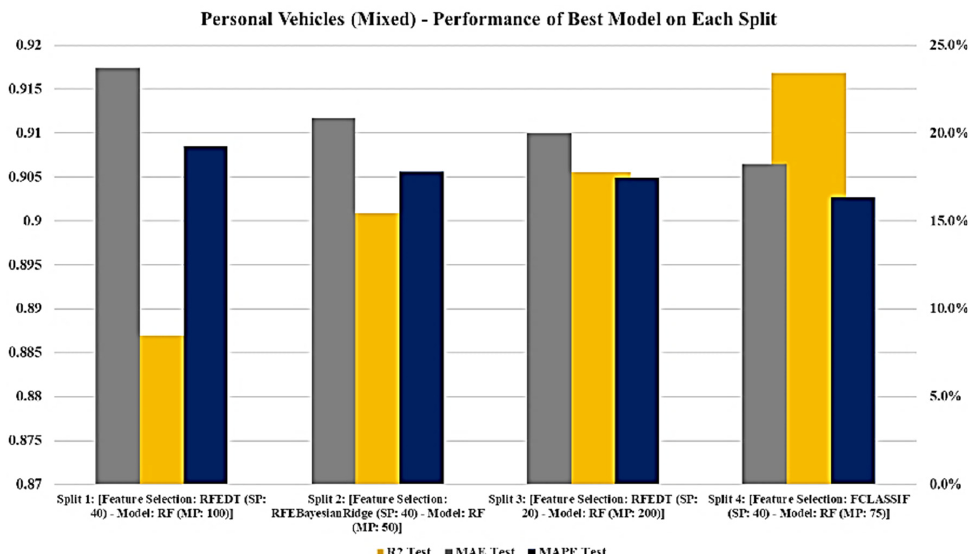
the right, presents the MAPE and MAE error).